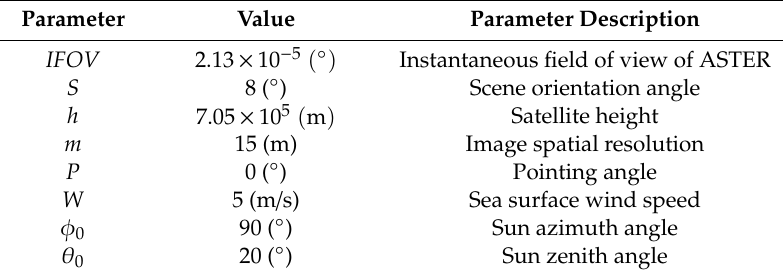
Table 1. Simulation model parameter